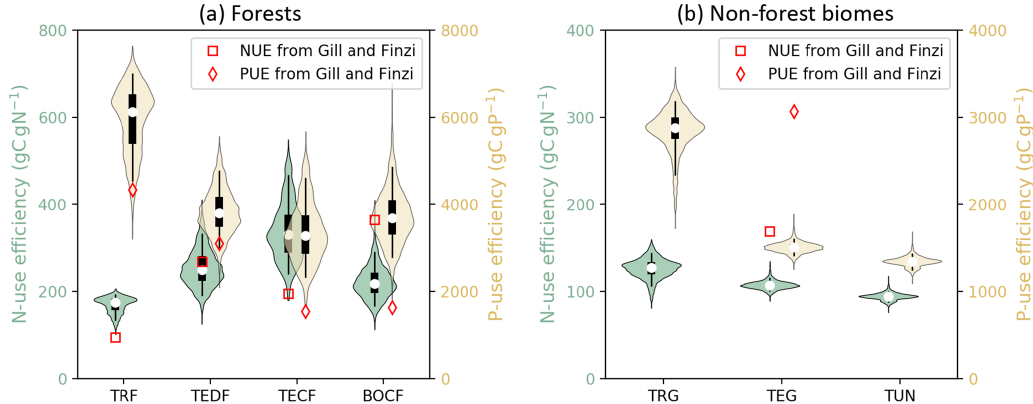
Figure 7. Violin plots of N- and P-use efficiencies (NUE and PUE, the nutrient uptake by plants divided by GPP) of seven biomes. Open circles are medians of all grid cells within each biome, with balloons representing the probability density distribution of each value. Black whiskers indicate the interquartile (thick) and 95% confidence intervals (thin). (a) Forest biomes, including tropical rainforests (TRF), tem- perate deciduous (TEDF), temperate coniferous (TECF), and boreal coniferous forests (BOCF). (b) Grassland biomes, including tropical/C 4 (TRG), temperate/C 3 grasslands (TEG), and tundra (TUN). Red squares (NUE) and diamonds (PUE) are the independent estimates from site observations and other generic data sets compiled and harmonized by Gill and Finzi (2016) based on site measurements of GPP and net N / P